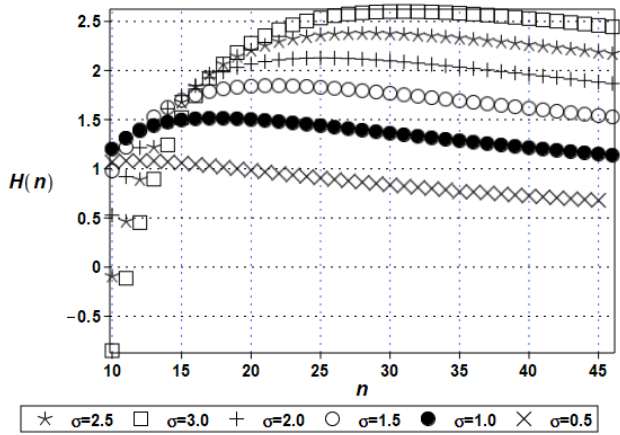
Figure 4. Convergence rate for the interval entropy computations.